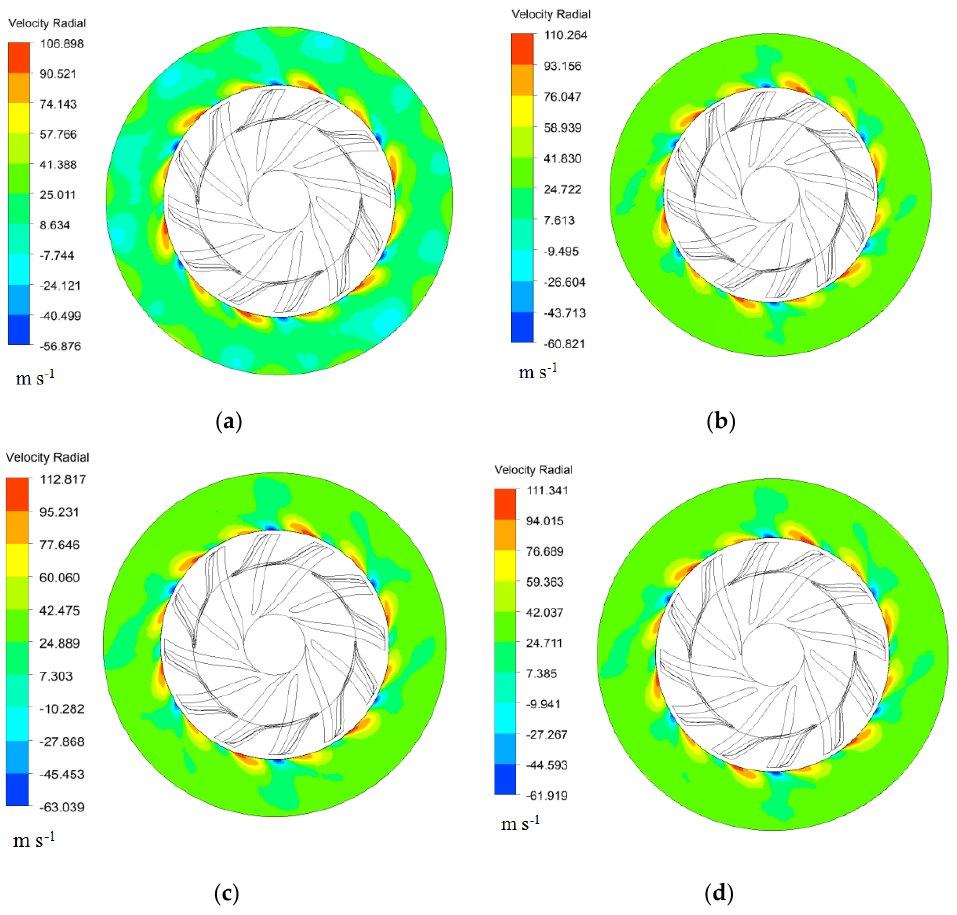
Figure 8. Seventy percent span height radial velocity distribution at 1.125 relative mass flow: ( a ) parallel; ( b ) convergence from shroud; ( c ) convergence from hub; ( d ) equal convergence from shroud and hub.